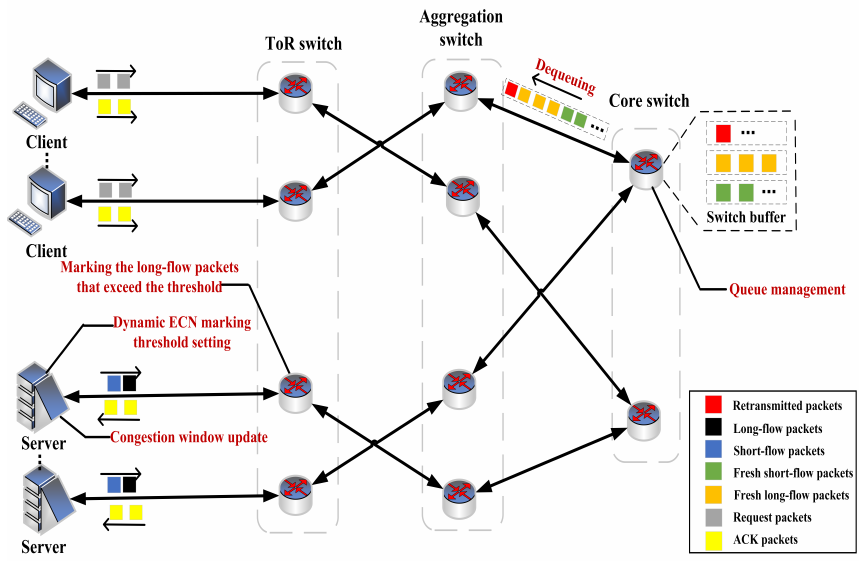
Figure 2. The architecture of